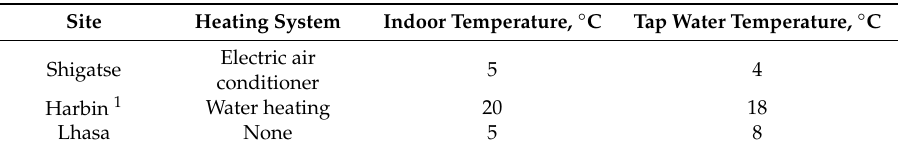
Table 2. Temperature conditions of laboratories.